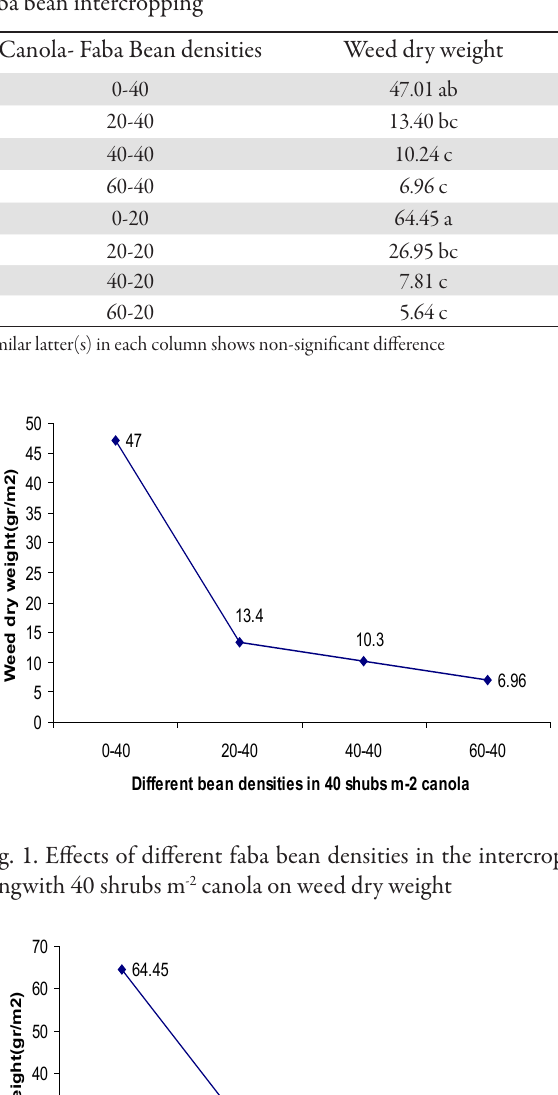
Tab. 2. Weed dry weights by different densities of canola and